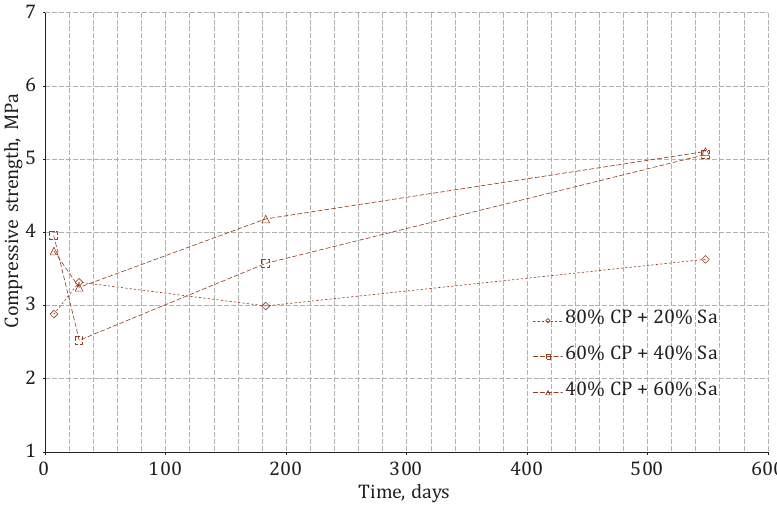
Figure 10. Updated compressive strength of samples (80% Portland cement + 20% fly ash) after Zakarka et al.